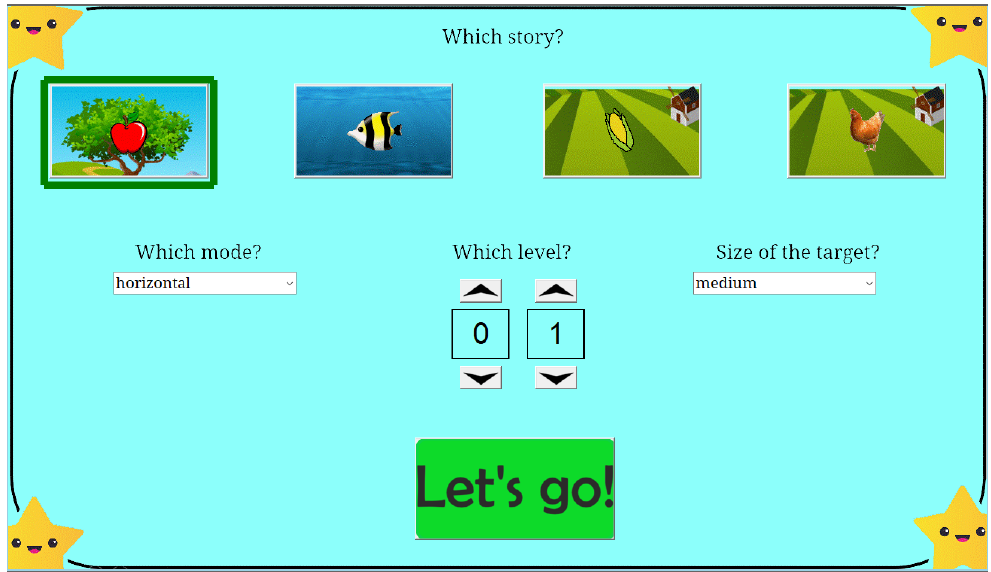
Figure 15. Menu of the game where the user can choose among four different game scenarios. The possible game modes are “vertical motion”, “horizontal motion”, ’limited time” and “evaluation”. The level corresponds to the number of objects the patient will have to catch. The size of the targets can be chosen between “small”, “medium” and “large”.